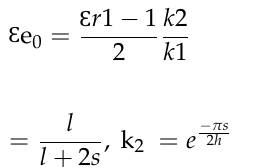
Figure 3. Evolution of the RDRA wideband antenna (3-D View) ( a ) Antenna-A, RDRA with the T- shape feed; ( b ) antenna-2, RDRA with a novel flat surface metal strip (Yagi-Uda); ( c ) desired wideband RDRA with the parasitic